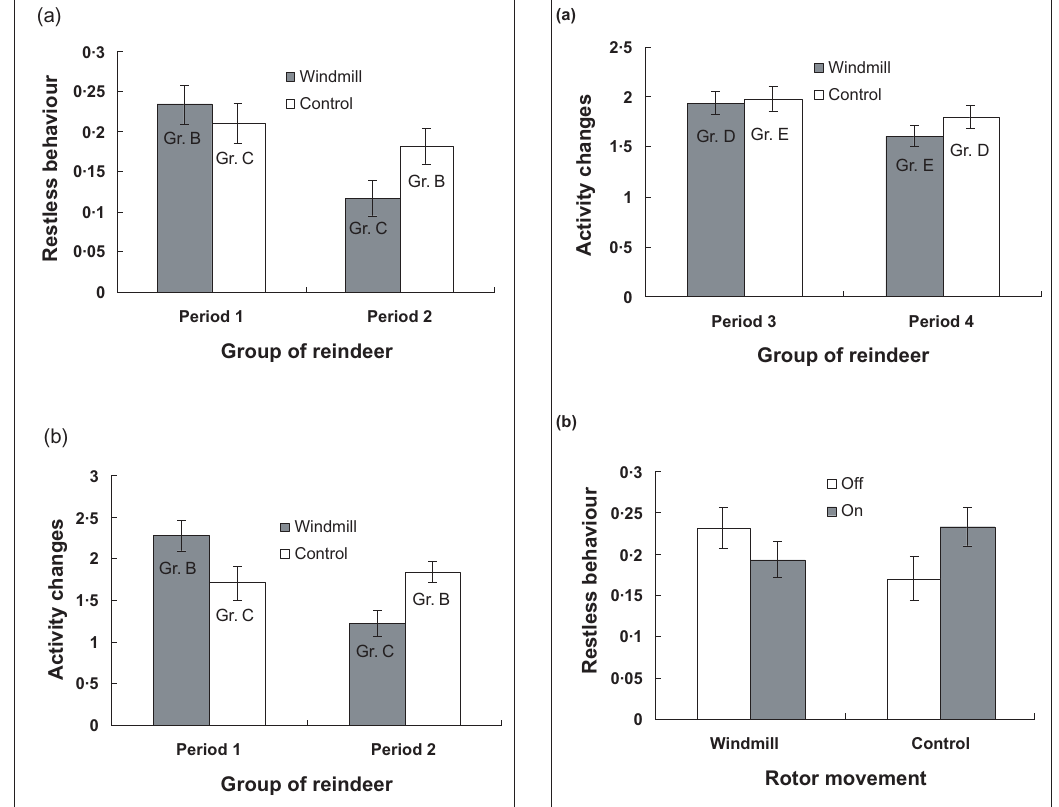
Fig. 4. The proportion of restless behaviour (a) and the frequen- cy min -1 of activity changes (b), in relation to enclosure and reindeer group for period 1 and 2 in 2000. Bars: standard error of the mean.